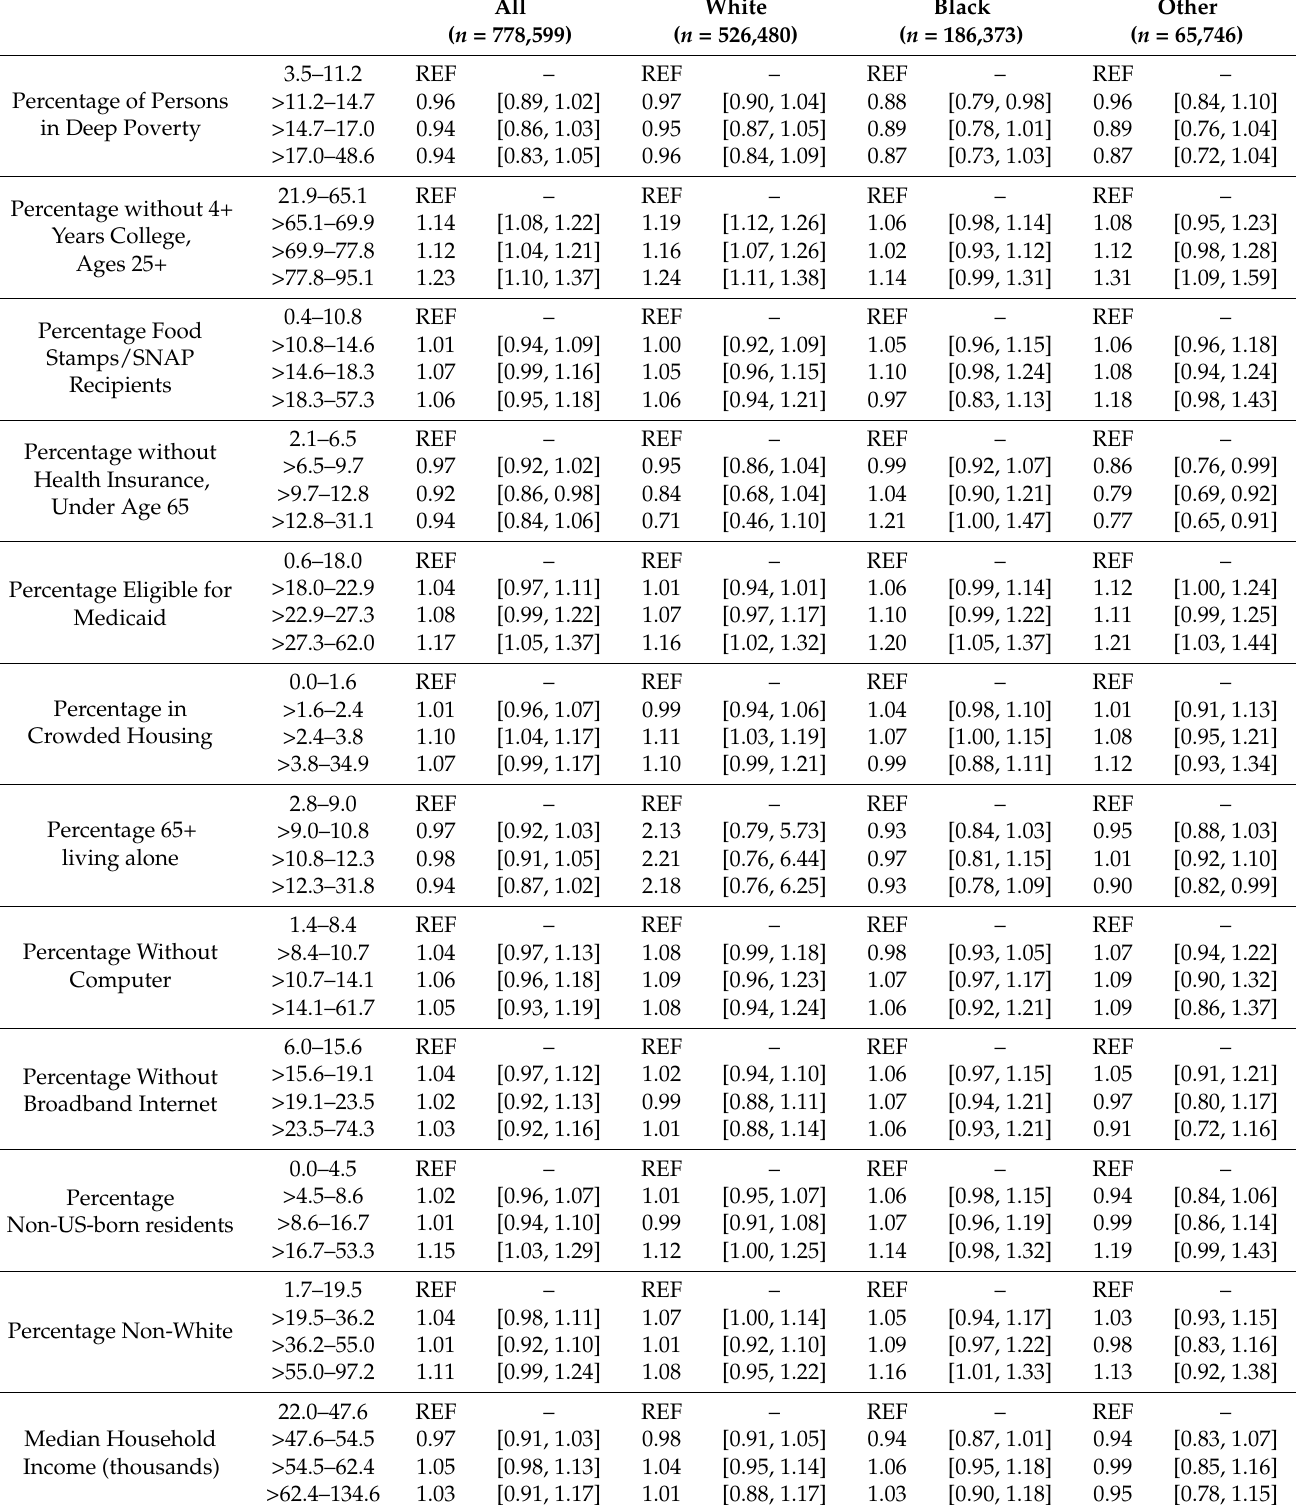
Table 2. Adjusted risk ratios (95 CI) for receiving a positive COVID-19 test result among Veterans enrolled in active care